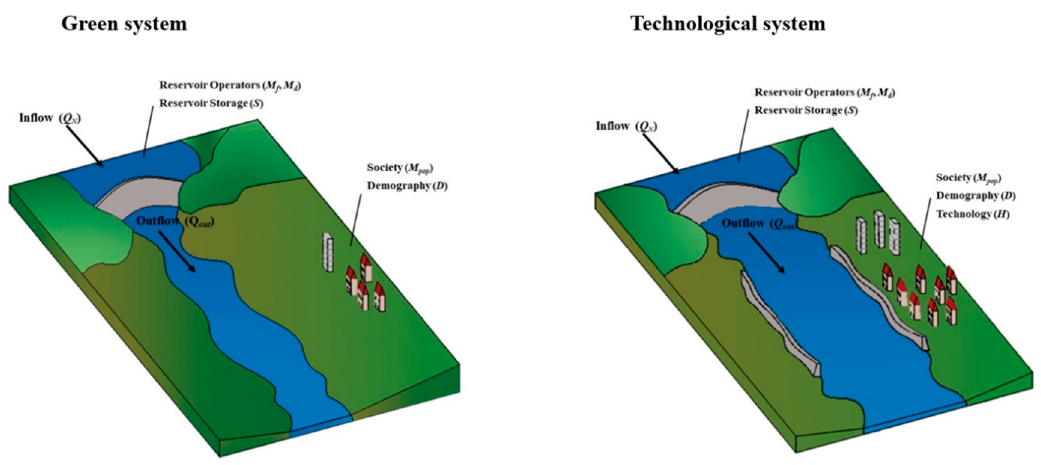
Figure 2. Schematic representation of green ( left side ) and technological ( right side ) systems settled on a floodplain downstream from the reservoir with the identification of the main state variables of the proposed socio-hydrological model.